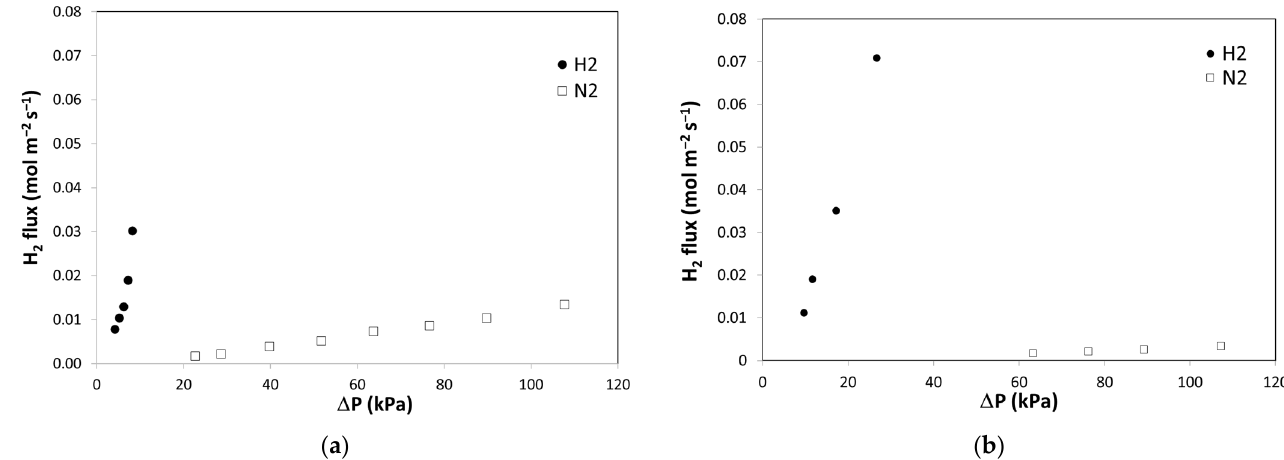
Figure 5. Hydrogen and nitrogen fluxes measured in ZrVTiPd2 ( a ) and ZrVTiPd3 ( b ) as a function of the pressure difference between feed and permeate sides.